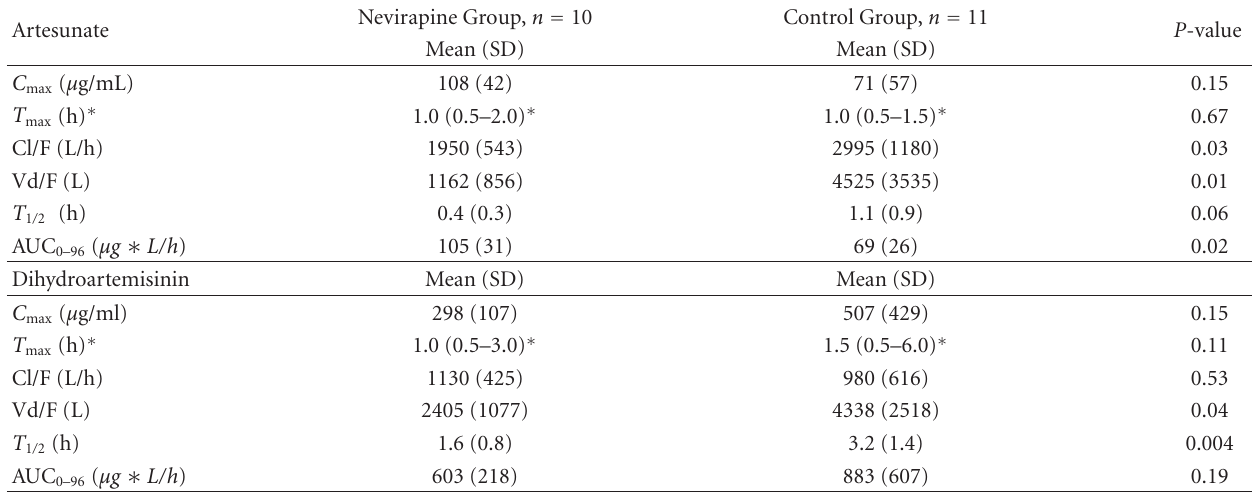
Table 1: Comparison of pharmacokinetic parameters of artesunate and